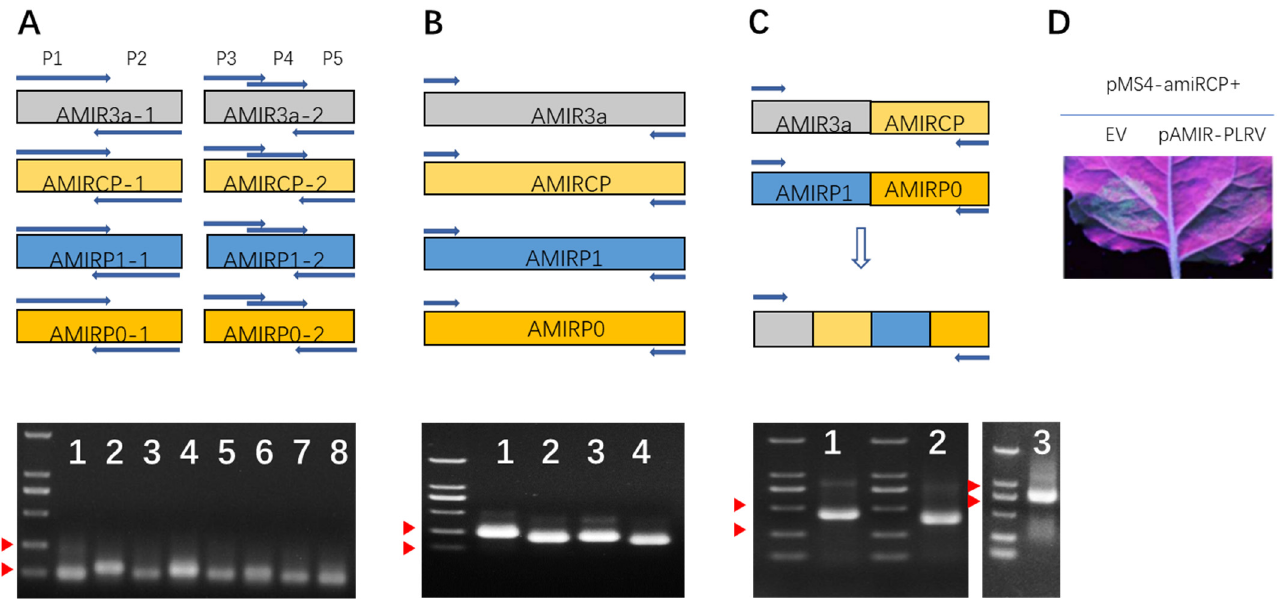
Figure 2. Synthesis of AMIR unit and cluster using fusion PCR protocol. ( A ) top, structure of subunits 1 and 2 of each AMIR, arrows on top of each subunit represent primers 1 to 5 (not drawn to scale); bottom, agarose gel image of the first-round PCR products, red arrowheads point to DNA ladders of 100 and 250 nt, respectively. ( B ) Structure and product of second-round PCR resulting in four individual AMIRs. Red arrowheads point to DNA ladders of 250 and 500 nt, respectively. ( C ) The third- and fourth-round PCR, producing double and quadruple AMIR clusters. Red arrowheads point to DNA ladders of 500 and 750 nt, respectively. ( D ) Transient assay in Nicotiana benthamiana leaf, photo taken at 3 day post-agrobacterium infiltration under UV light. Red arrowheads point to DNA ladders of 750 and 1000 nt, respectively.